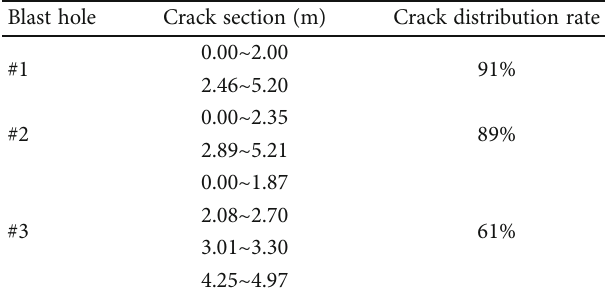
Figure 8: Blast hole layout Table 2: Observation of the e ff ects of blast hole formation.